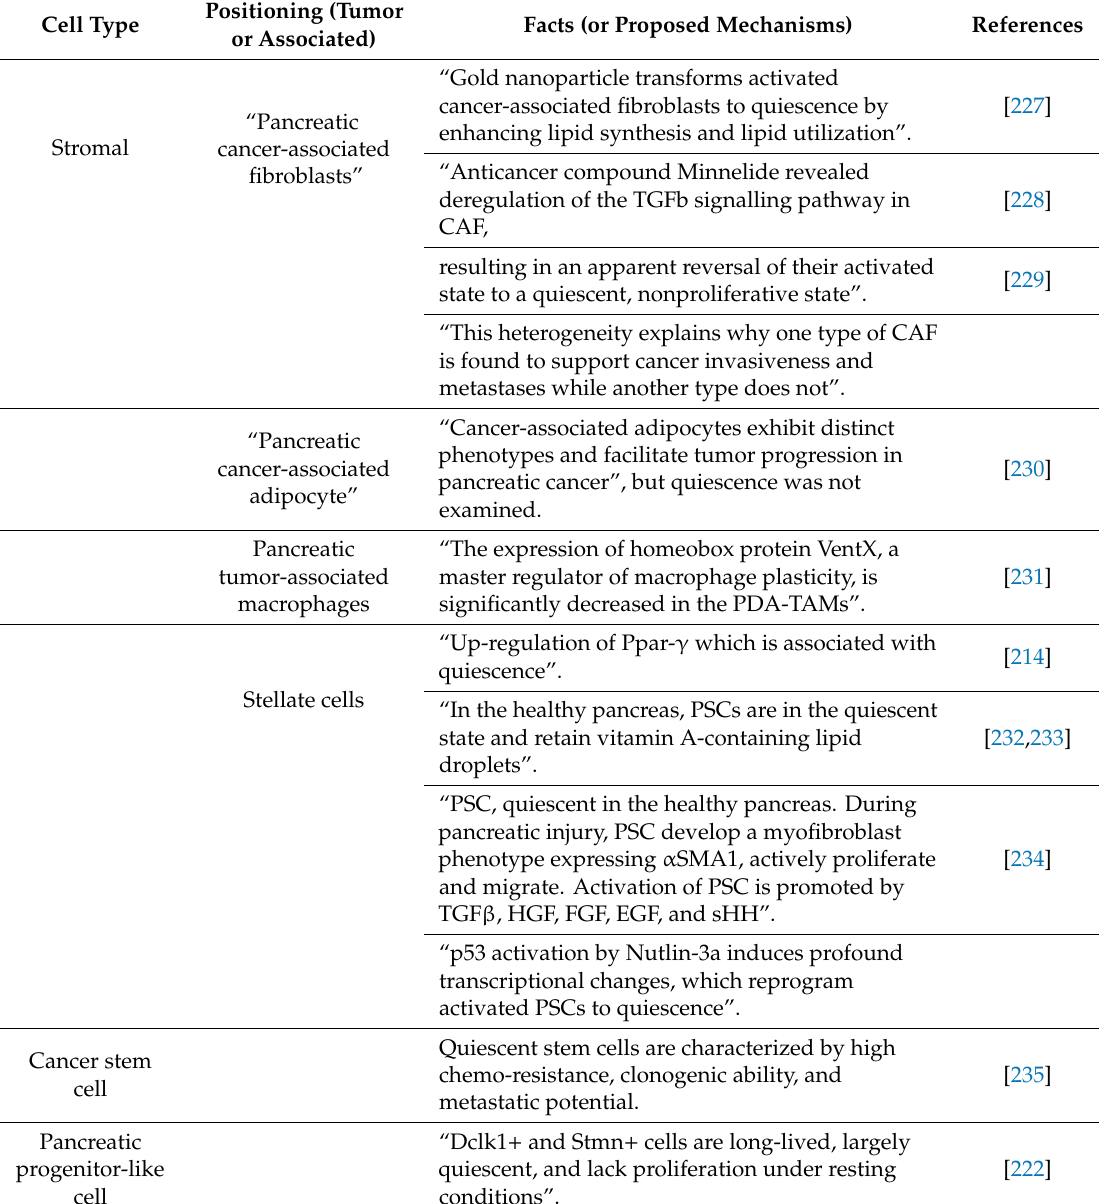
Table 3. Mechanisms involved in quiescence of di ff erent pancreatic cancer cell